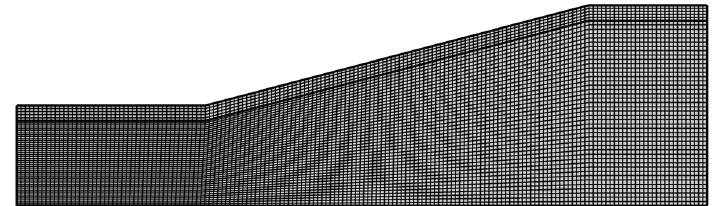
Figure 2. Finite-element mesh of the canal.